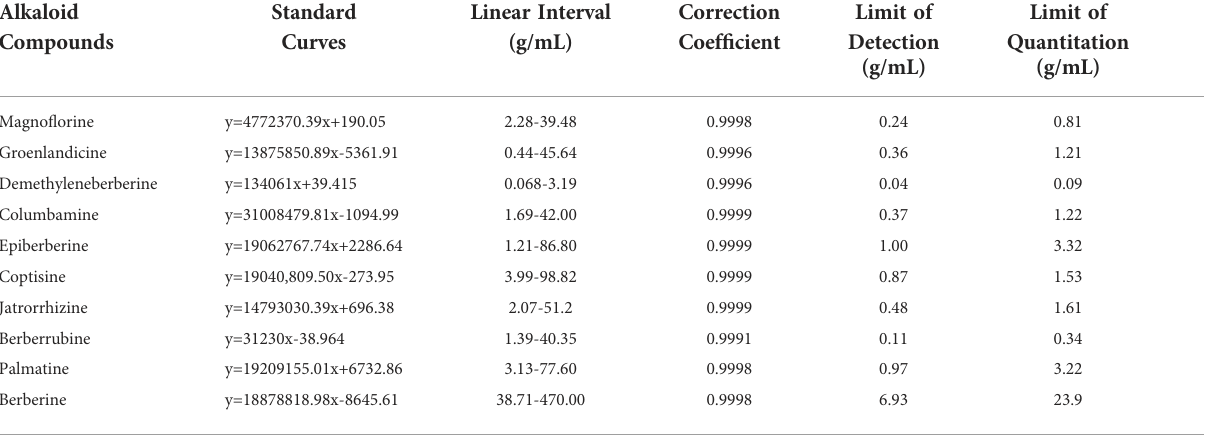
TABLE 1 The methodological parameters of the UPLC − MS/MS method. Alkaloid Standard Linear Interval Correction Limit of Compounds Curves Coef fi cient